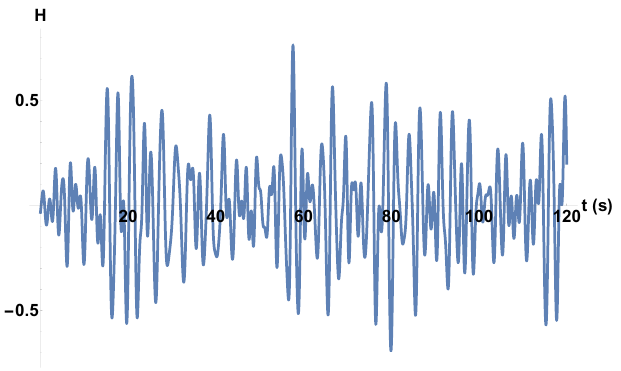
Fig. 10. The free surface elevation above the cyclorotors centre x = 0